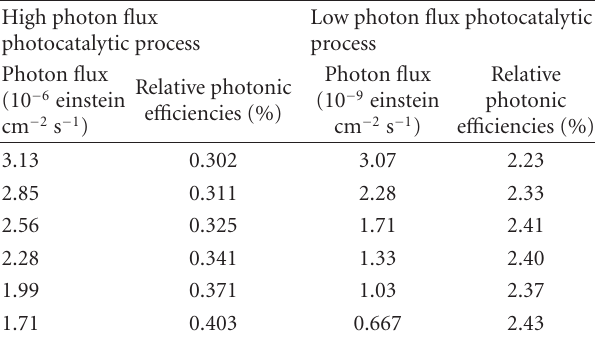
Table 1: Relative photonic e ffi ciencies of photocatalytic degrada- tion of MB under di ff erent photon